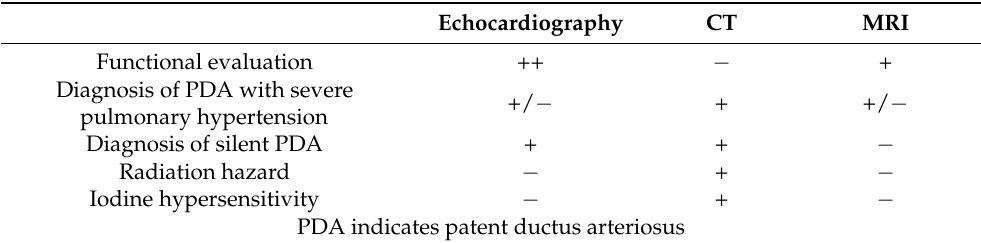
Table 1. Pros and cons of the echocardiography, CT, and MRI in the evaluation of PDA.